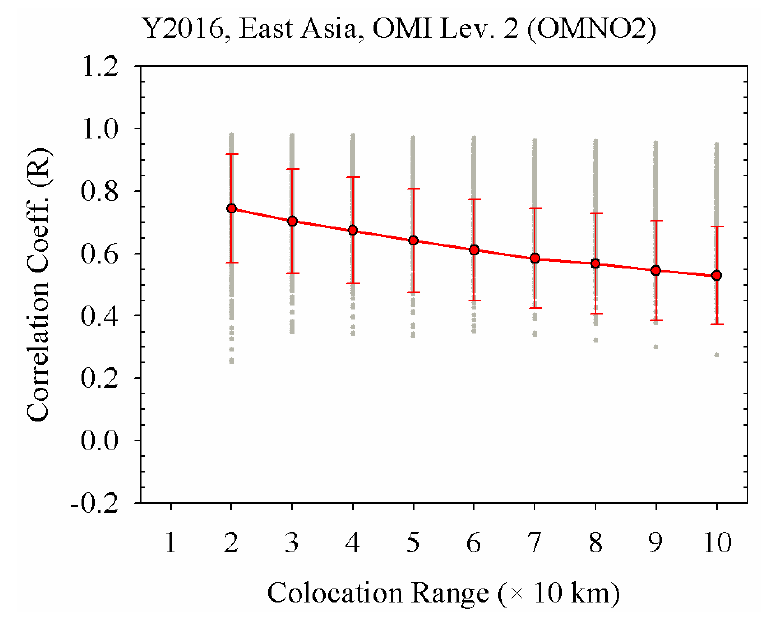
Figure 7. Distribution of correlation coefficient (R d ) for TCN in East Asia with respect to the colocation range.